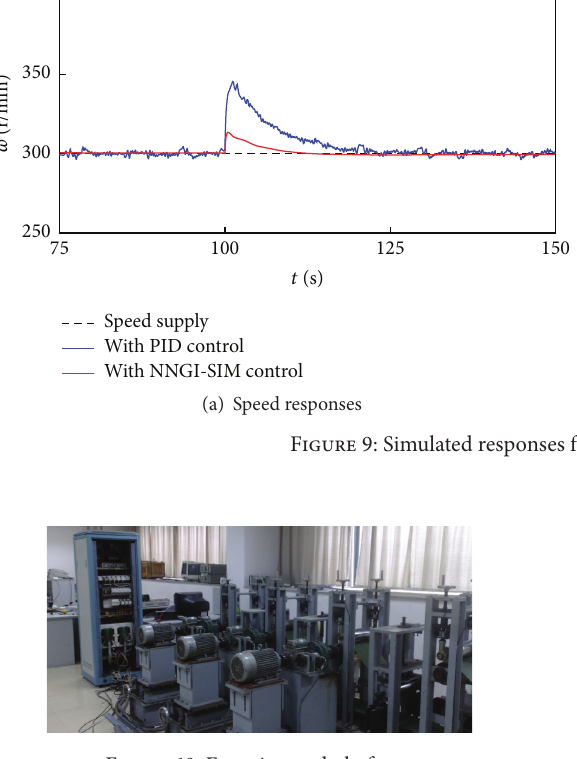
Figure 10: Experimental